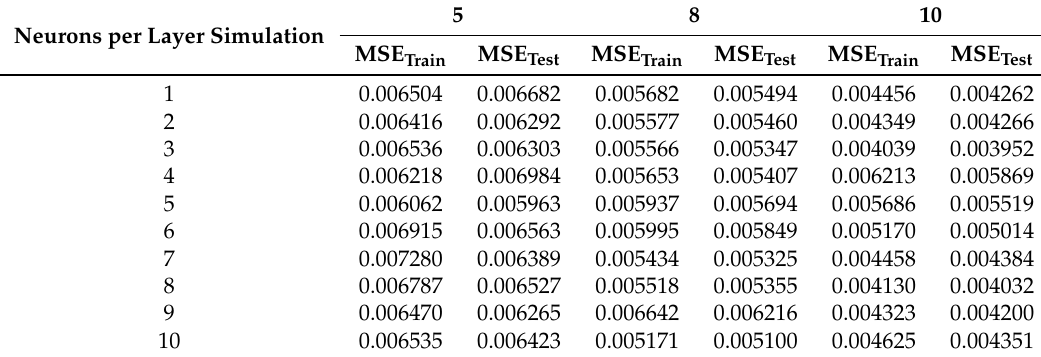
Table 4. Mean Squared Error of the Yeast Fermentation Reactor Temperature model for several modelling approaches of with different number of neurons and with two hidden layers.